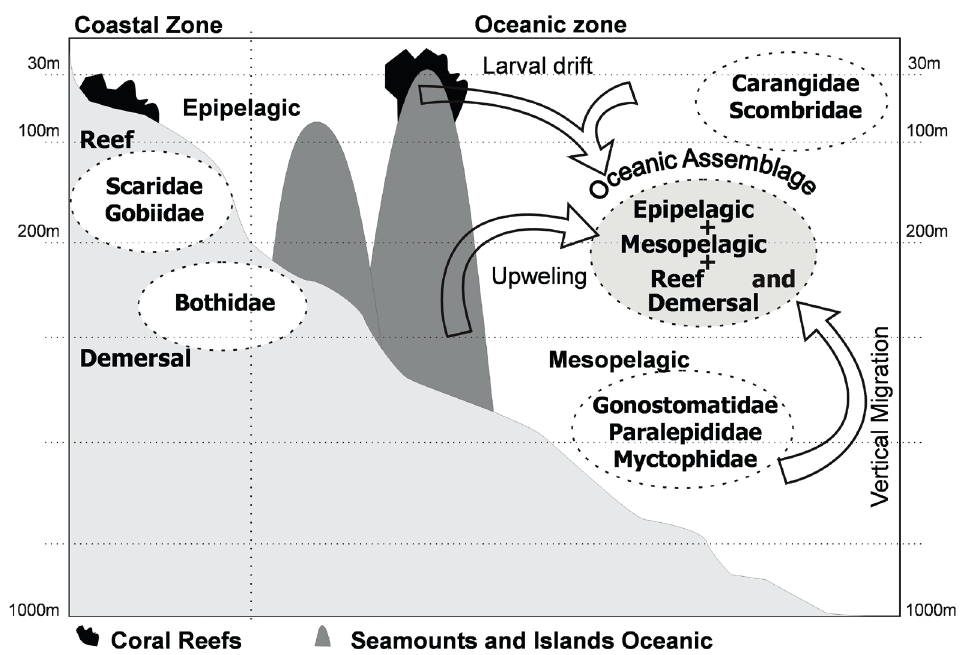
Figure 8 - Conceptual model of the fish larvae assemblage in the west tropical Atlantic